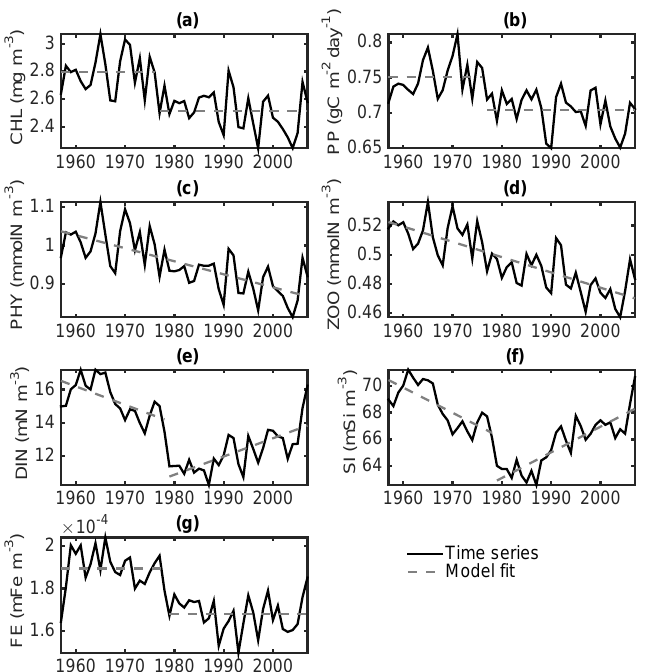
Figure B2. Time series of (a) surface chlorophyll, (b) integrated primary production, (c) total surface phytoplankton, (d) zooplankton biomass and (e) surface dissolved inorganic nitrogen, (f) silica and (g) iron simulated with the DiatHadOCC model and averaged over the Gulf of Alaska region. The dotted lines represent the statistical model selected.